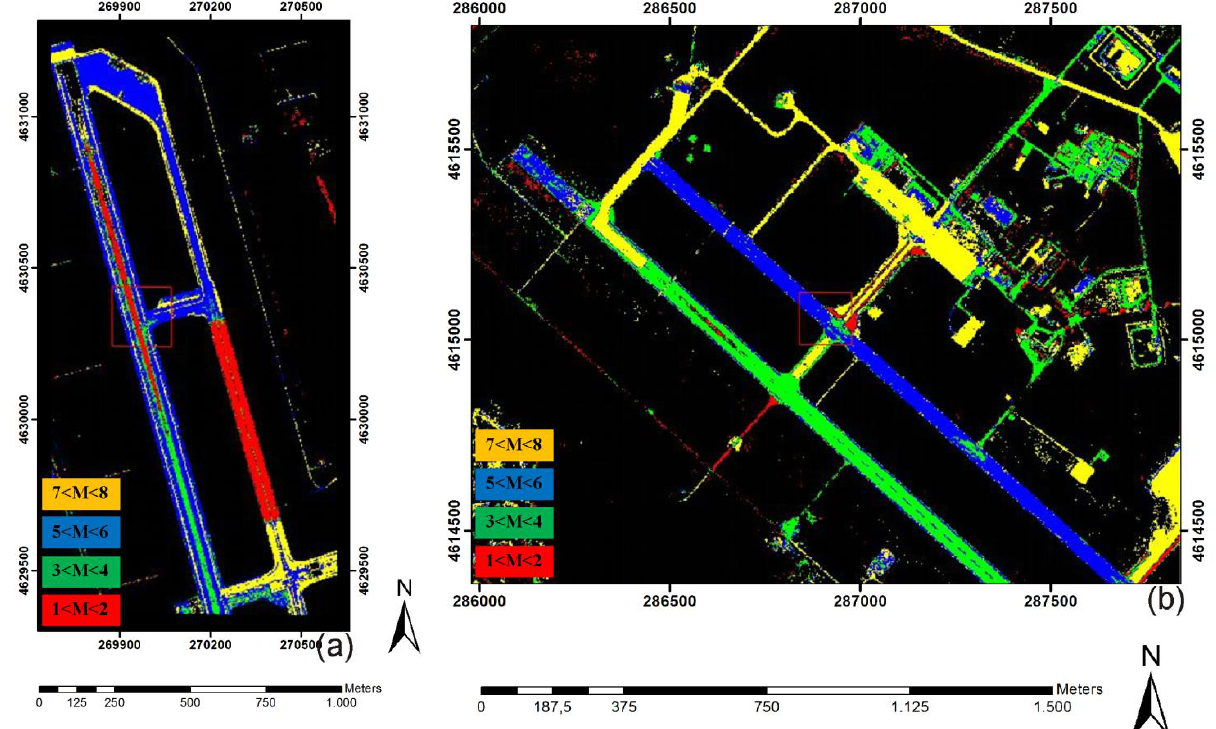
Figure 9. ( a ) Leonardo Da Vinci Airport-Ikonos (about 1 × 1.9 km); ( b ) Pratica di Mare airport-Quickbird (about 1.9 × 1.5 km). (UMT-WGS 84 zone